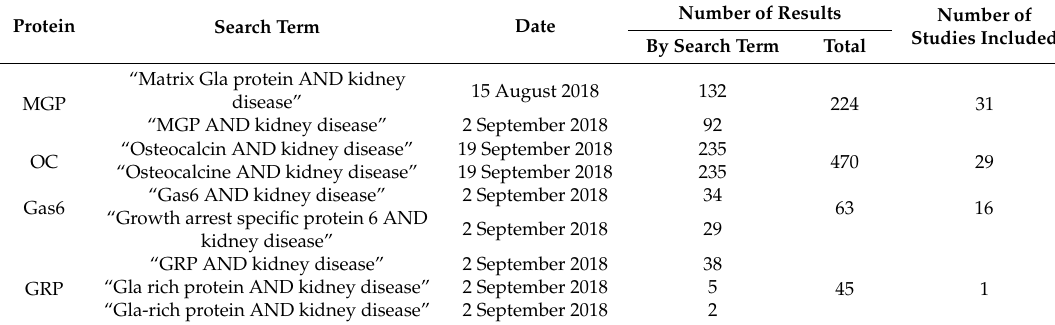
Table 1. Summary of searching